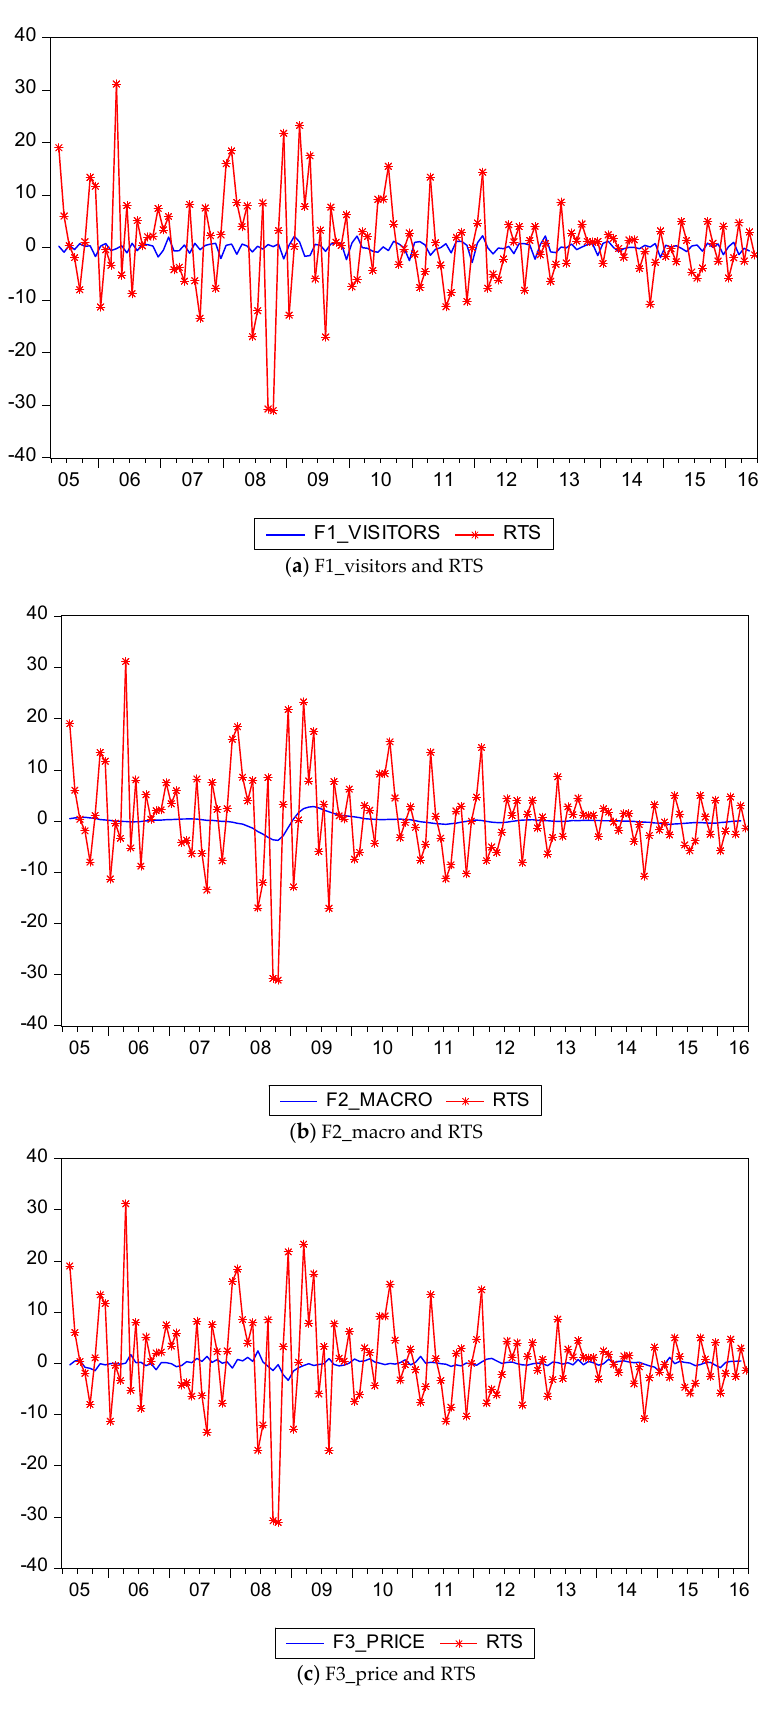
Figure 5. Time series for factors and RTS (April 2005–June 2016). Table 4. Granger causality tests on TFCI and RTS for April 2005–June 2016.